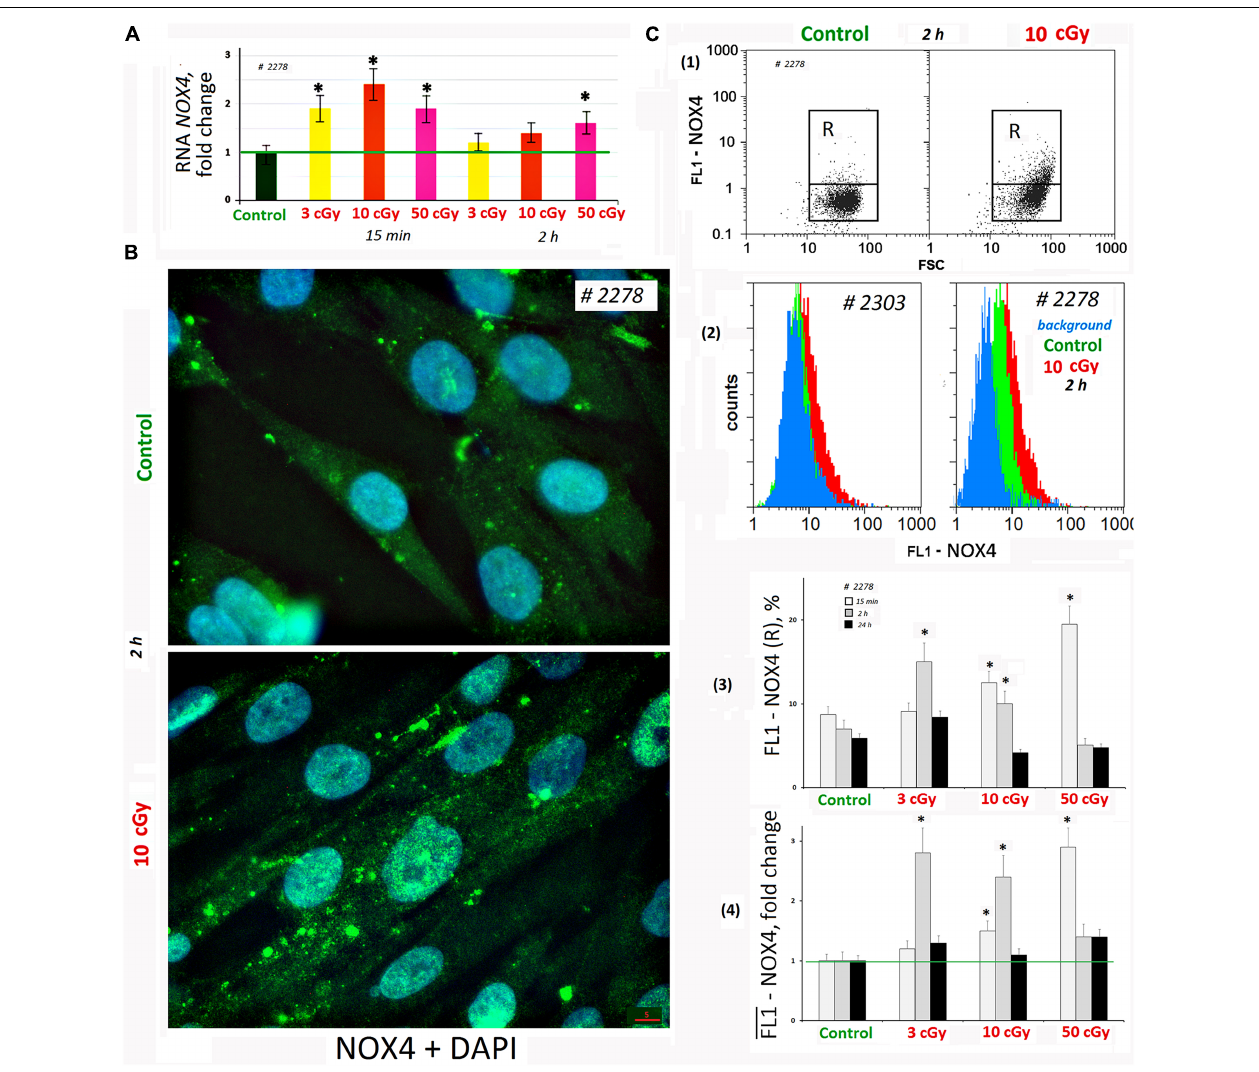
FIGURE 3 | LDIR induce expression of NOX4 in MSCs. (A) Quantitative reverse transcriptase–polymerase chain reaction. NOX4 RNA levels changes in treated cells (15 min or 2 h after LDIR) compared to control. Average values and SD are given for three experiments. Reference gene TBP . * p < 0.001 ( U test). (B) Fluorescence microscopy. Localization of FITC-labeled antibody against NOX4 in the irradiated MSC (10 cGy, 2 h after LDIR) and control MSC. (C) FACS. (1) Plots: FL1-NOX4 versus SSC. R: gated area, cells with an increased NOX4 expression. (2) The distribution of #2278 and #2303 MSCs (10 cGy, 2 h after LDIR) with varying FL1-NOX4 signal. To quantify the background fluorescence, we stained a portion of the cells with secondary FITC-conjugated antibodies only (blue color). (3) The content of the cells with an increased level of NOX4 expression (gate R). (4) Median signals for FL1–NOX4. Signals are normalized to control values. Average values and SD are given for three experiments. * p < 0.001 ( U